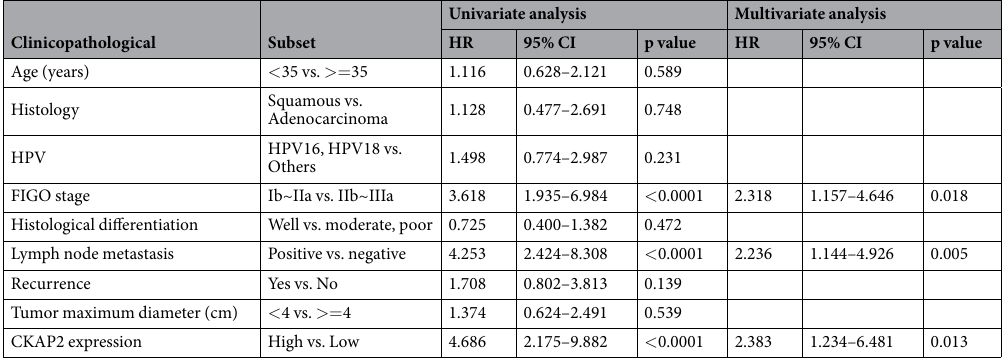
Table 3. Univariate and multivariate analysis of clinicopathological factors for overall